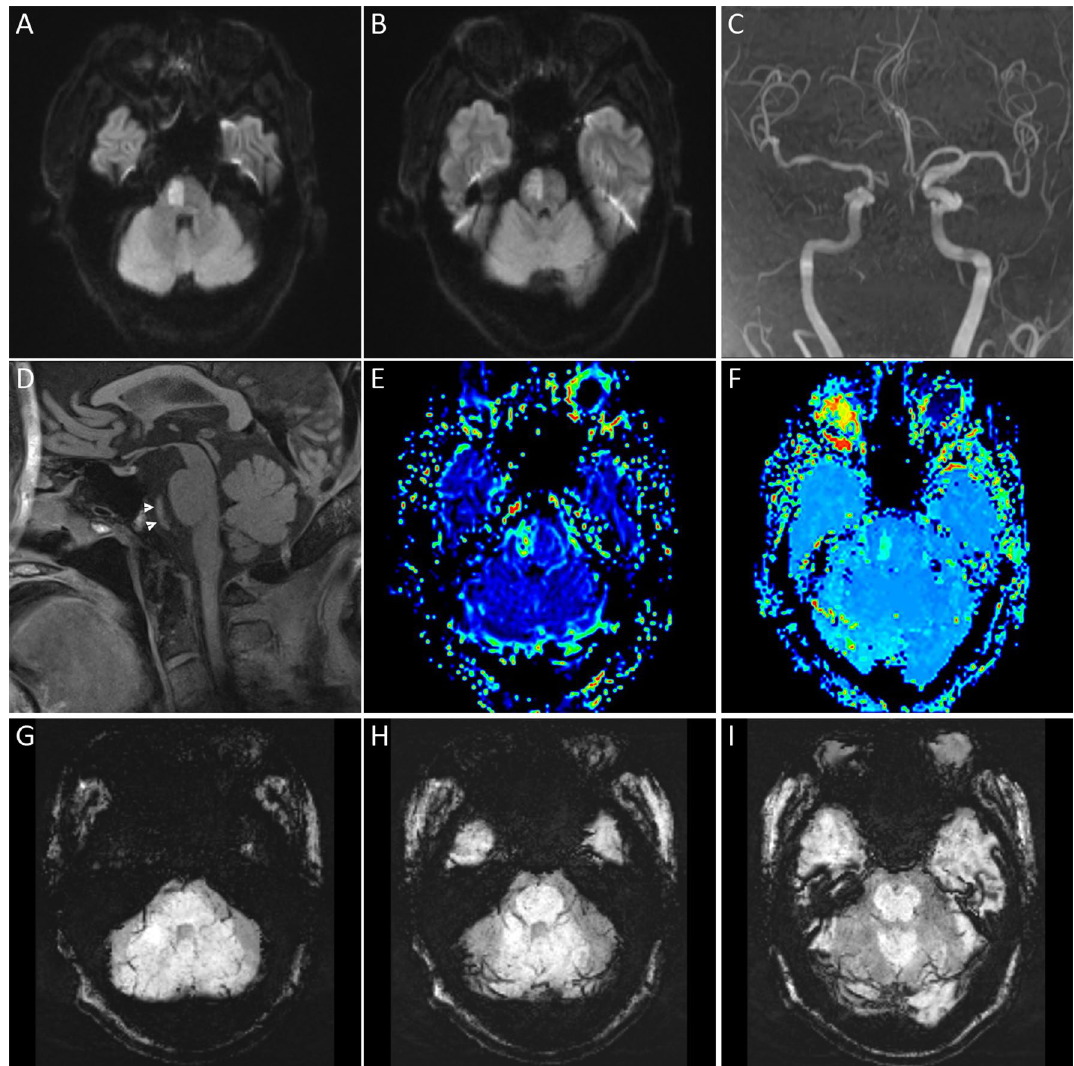
Figure 3. Prominent vessel sign was not displayed in a patient with posterior circulation occlusion. DWI ( A , B ) showed acute pontine infarction. MRA ( C ) and 3D-SPACE ( D ) indicated occlusion of the basilar artery (white arrowheads). The MTT ( E ) and TTP ( F ) maps showed hypoperfusion at the infarct site. There was no asymmetric prominent hypointense vessels on SWI ( G – I ) in the posterior circulation